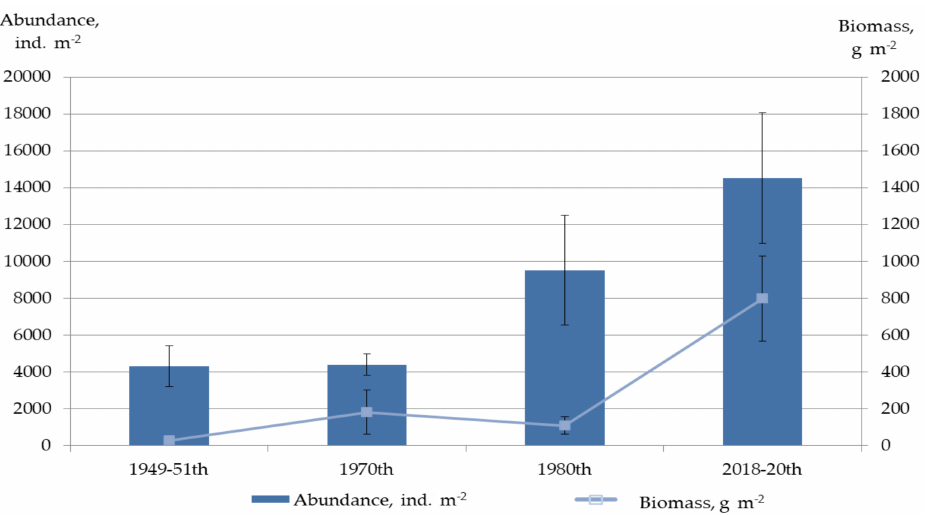
Figure 18. Long-term changes in the average ± SE abundance and biomass macrozoobenthos, calculated based on historical [2,3,6,9–11] and project